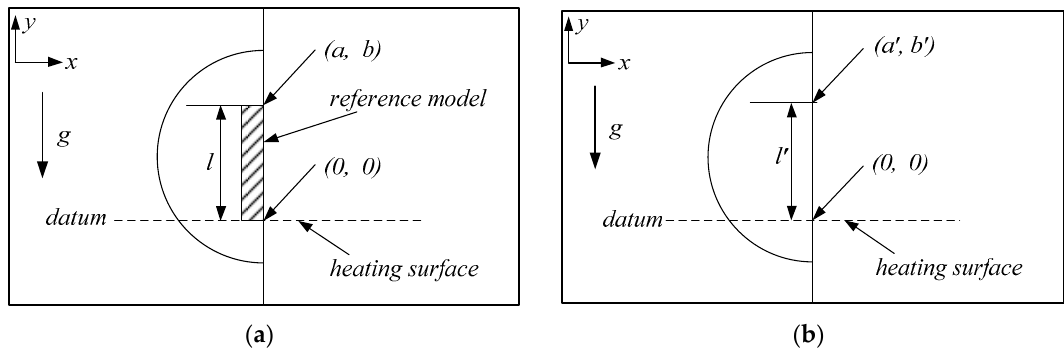
Figure 6. The methodology for the calculation of local position of fringe. ( a ) Reference, ( b ) Real state.